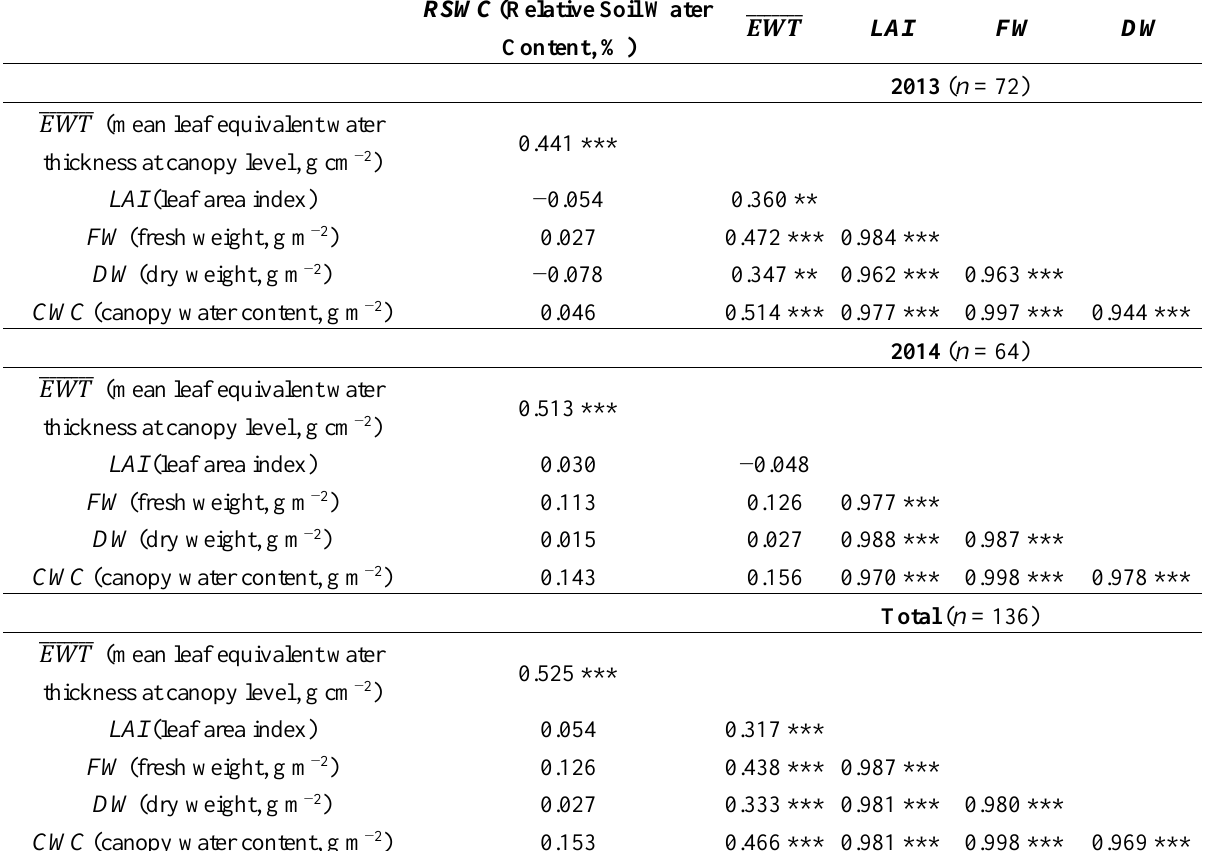
Table 5. Spearman’s rank correlation coefficients between CWC , 𝐸𝑊𝑇̅̅̅̅̅̅̅ and canopy biophysical variables and soil moisture during the 2013 and 2014 growing